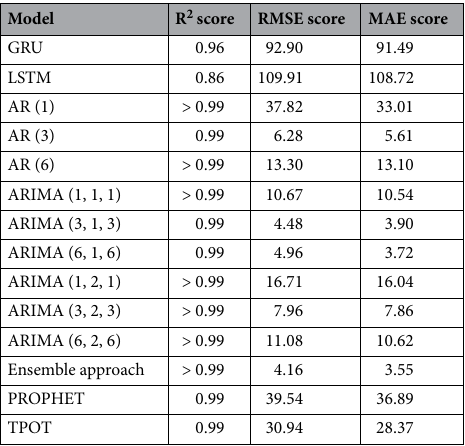
Table 3. 14-day CI accuracy prediction for the first dataset. Training from July 20, 2020 to November 29, 2020, Prediction from November, 30 to December, 4.